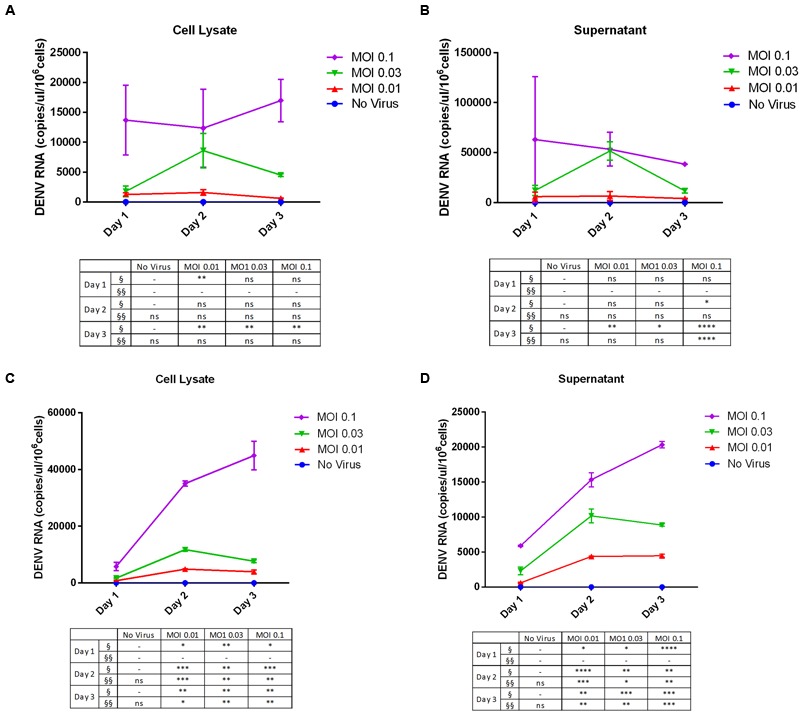
Dengue virus RNA copy number in infected cell lines. (A,B) THP-1 and (C,D) 293T cells were left uninfected or infected with DENV-3 at various MOIs (range: 0.01–0.1). Cells were harvested at various post-infection time points (days 1, 2, and 3). Total RNA was extracted from cell lysates and the culture supernatant and DENV genome copy number was determined by RT-qPCR. The table summarizes statistical analysis, ∗P < 0.05, ∗∗P < 0.01, ∗∗∗P < 0.001, ∗∗∗∗P < 0.0001 vs. control (uninfected cells; unpaired two-tailed t-test). Data represent mean ± SEM. § and §§ represent MOI- and time-dependent variables, respectively.